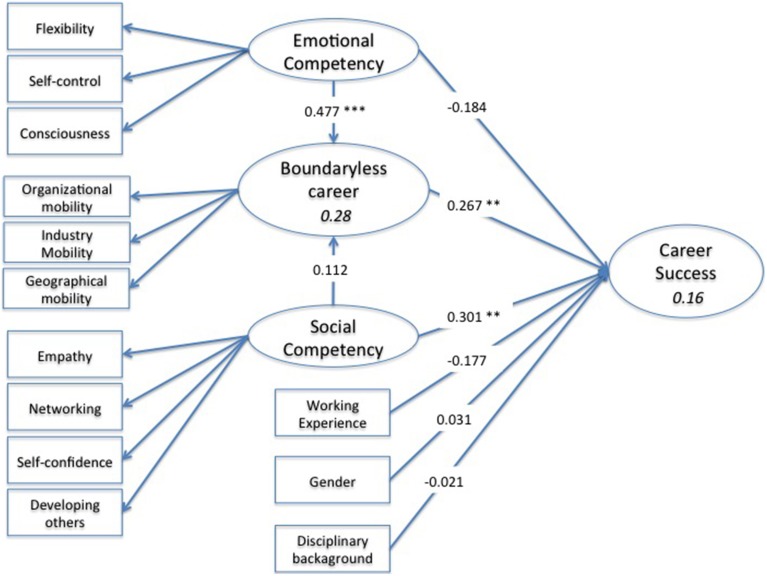
Reduced estimated model. *
p < 0.05; **
p < 0.01; ***
p < 0.001.